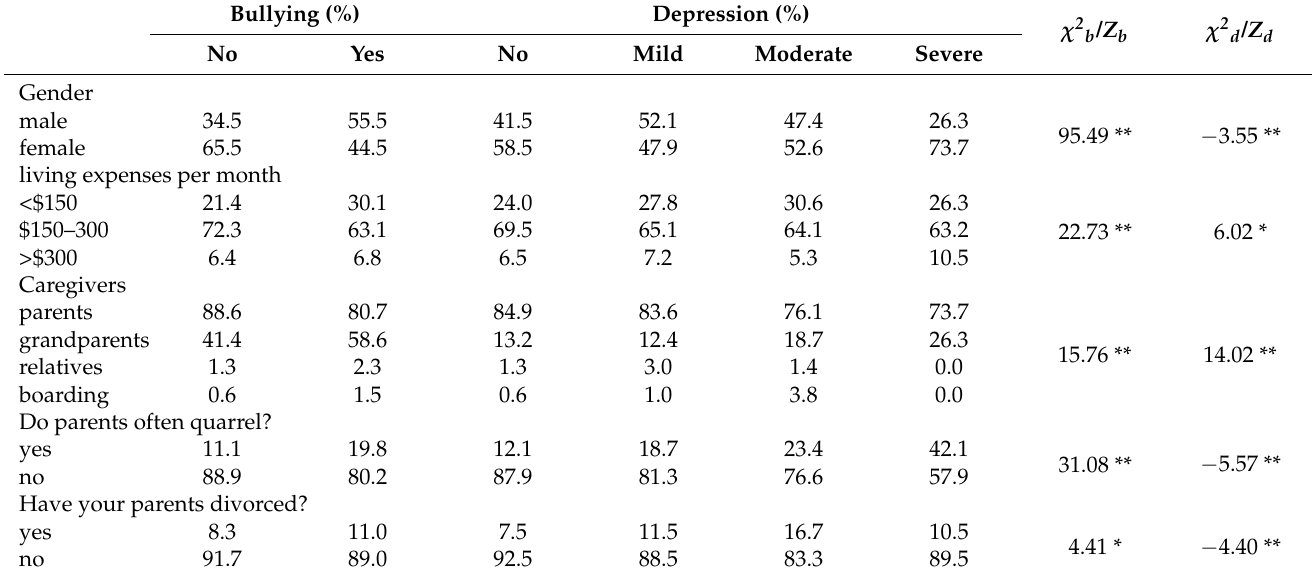
Table 1. Descriptive statistical analysis of having experienced bullying and